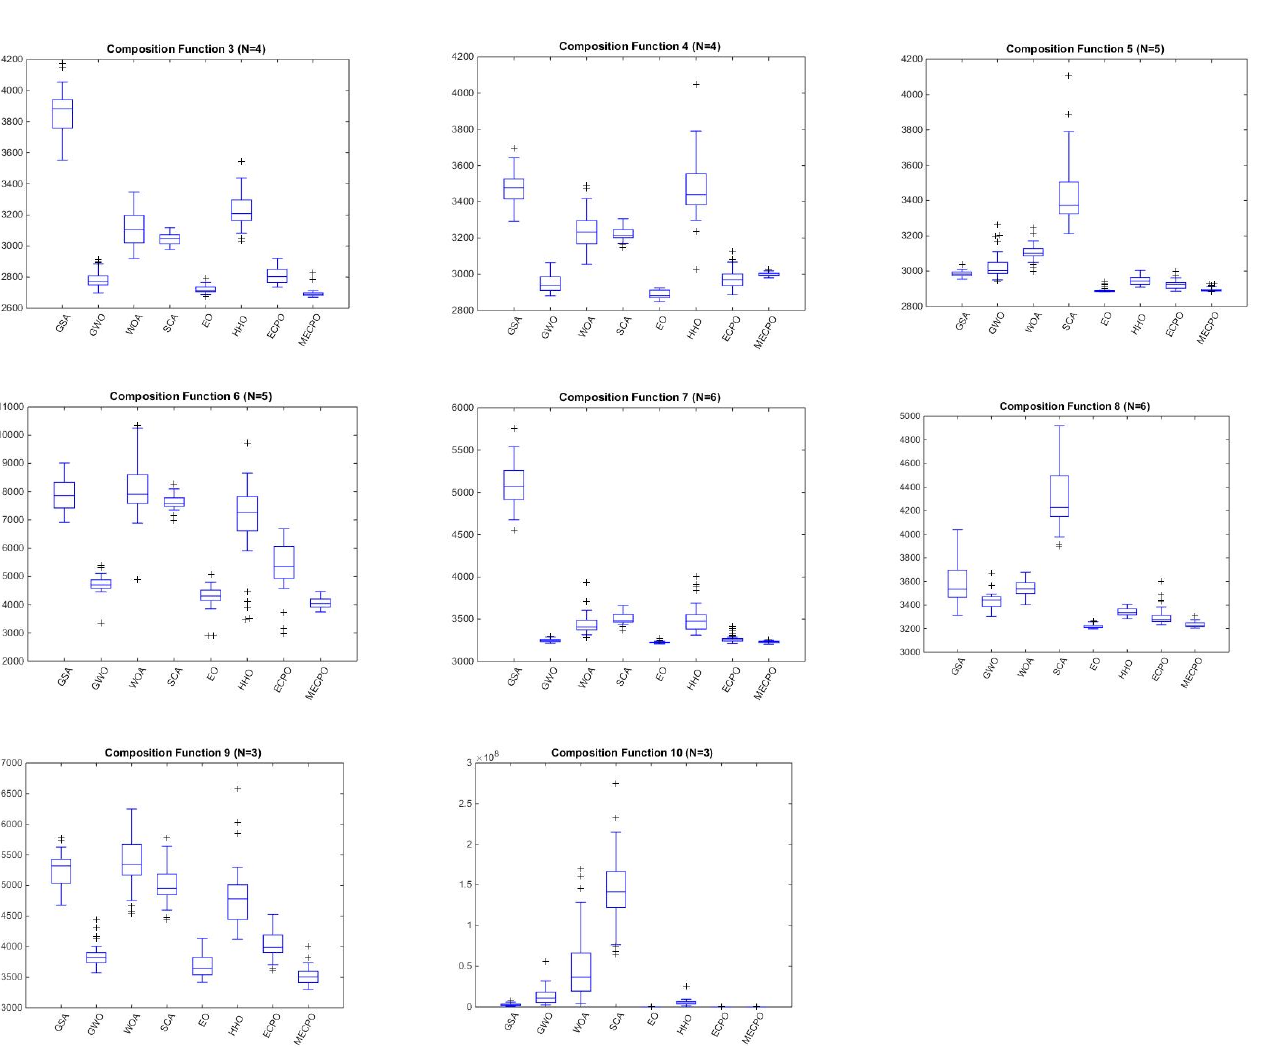
Figure 6. The boxplot curves of the MECPO technique and the other techniques achieved for CEC’17 functions with dimension = 30.